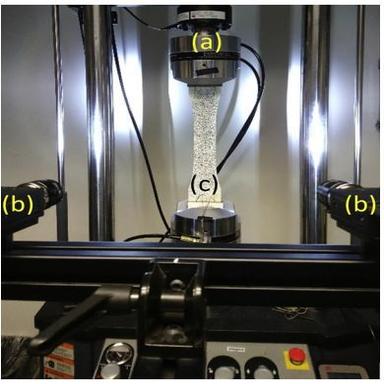
Specimen with optical instrumentation setup. (a) grips, (b) cameras, (c) specimen.